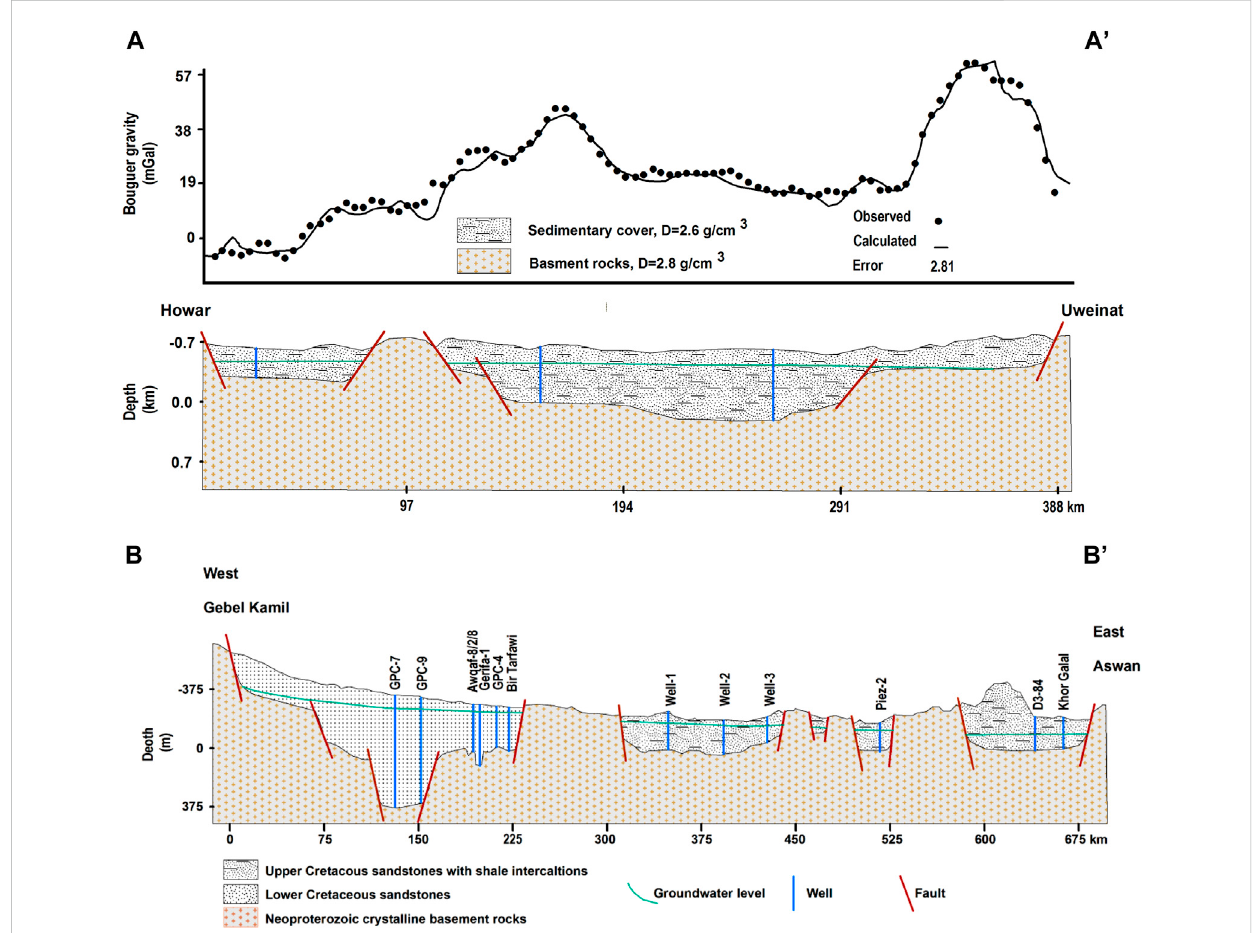
FIGURE 18 Two-dimensional gravity inversion model along pro fi le AA ’ (plotted on Figure 3). Also shown are the locations of the wells along or proximal to this pro fi le. And a schematic geological west – east cross-section along the Uweinat – Aswan uplift [Pro fi le BB ’ ; Figure 3] was generated from well data (Figure 7) and the basement relief map (Figure